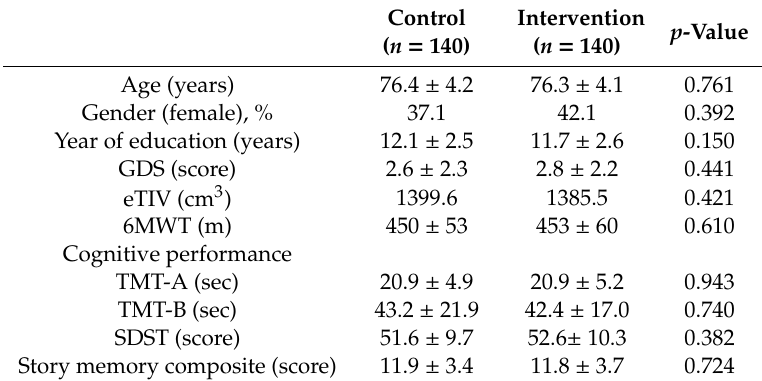
Table 1. Baseline characteristics of study participants.